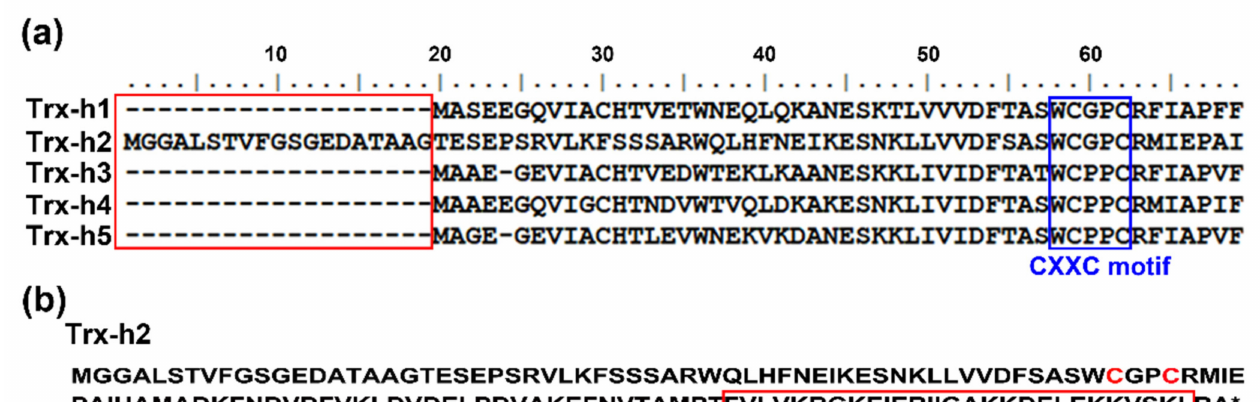
Figure 1. Comparison of the N-terminal amino acid sequences of the five representative Arabidopsis Trx-h proteins. ( a ) alignment of the N-terminal amino acid sequences of Arabidopsis Trx-h proteins. Two conserved cysteine (Cys) residues in the CXXC motif positioned between amino acids 59 and 62 are indicated in a blue box. The extra 19 amino acids at the N-terminus of Trx-h2 are outlined in a red box. Numbers above the alignment indicate the amino acid positions. ( b ) amino acid sequence of Trx-h2. Active Cys residues in the Trx motif are indicated in red, and the bipartite nuclear localization signal (NLS), identified using the NLS-mapper database, is outlined in red box. The asterisk (*) indicates the stop codon.